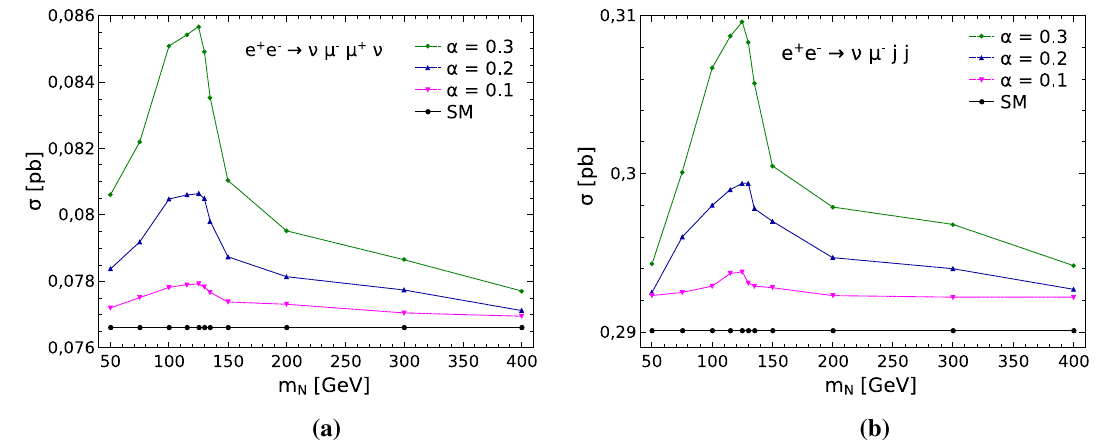
Fig. 2 Parton-level cross sections for the pure leptonic ( a ) and semi-leptonic ( b ) processes, with acceptance cuts (see